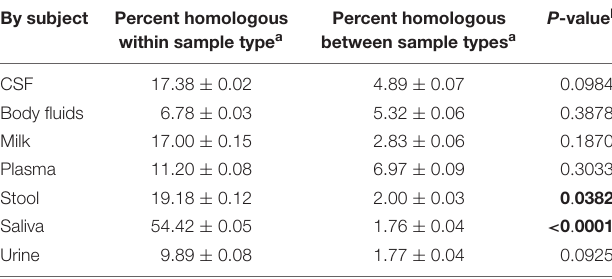
TABLE 1 | Viral homologs within and between specimen